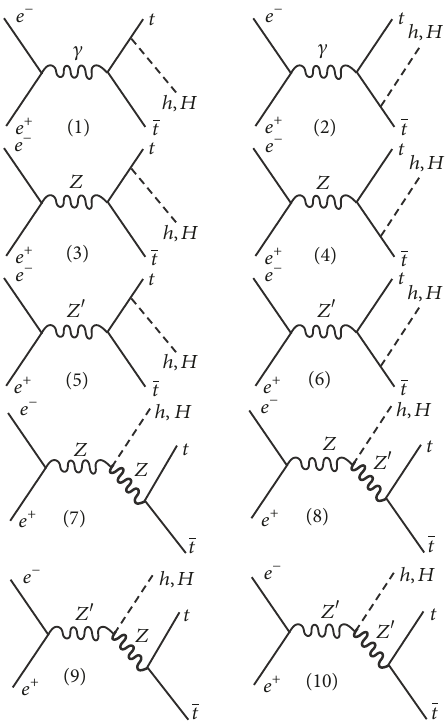
Figure 1: Feynman diagrams for the Higgs bosons production in association with 𝑡𝑡 pair 𝑒 + 𝑒 − 󳨀→ 𝑡𝑡ℎ and 𝑒 + 𝑒 − 󳨀→ 𝑡𝑡𝐻 in the B-L